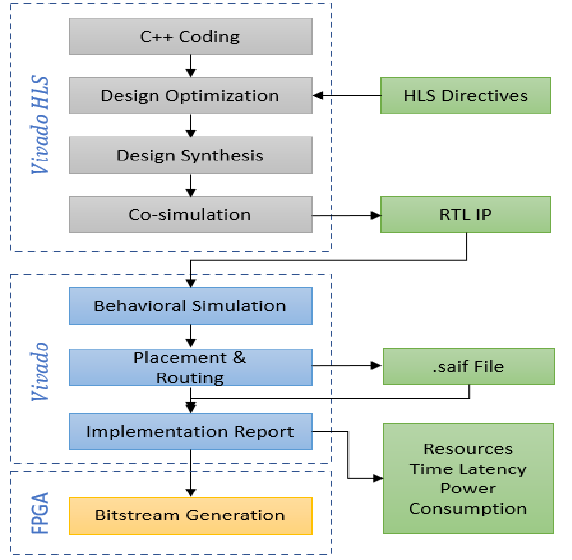
Figure 4. FPGA implementation